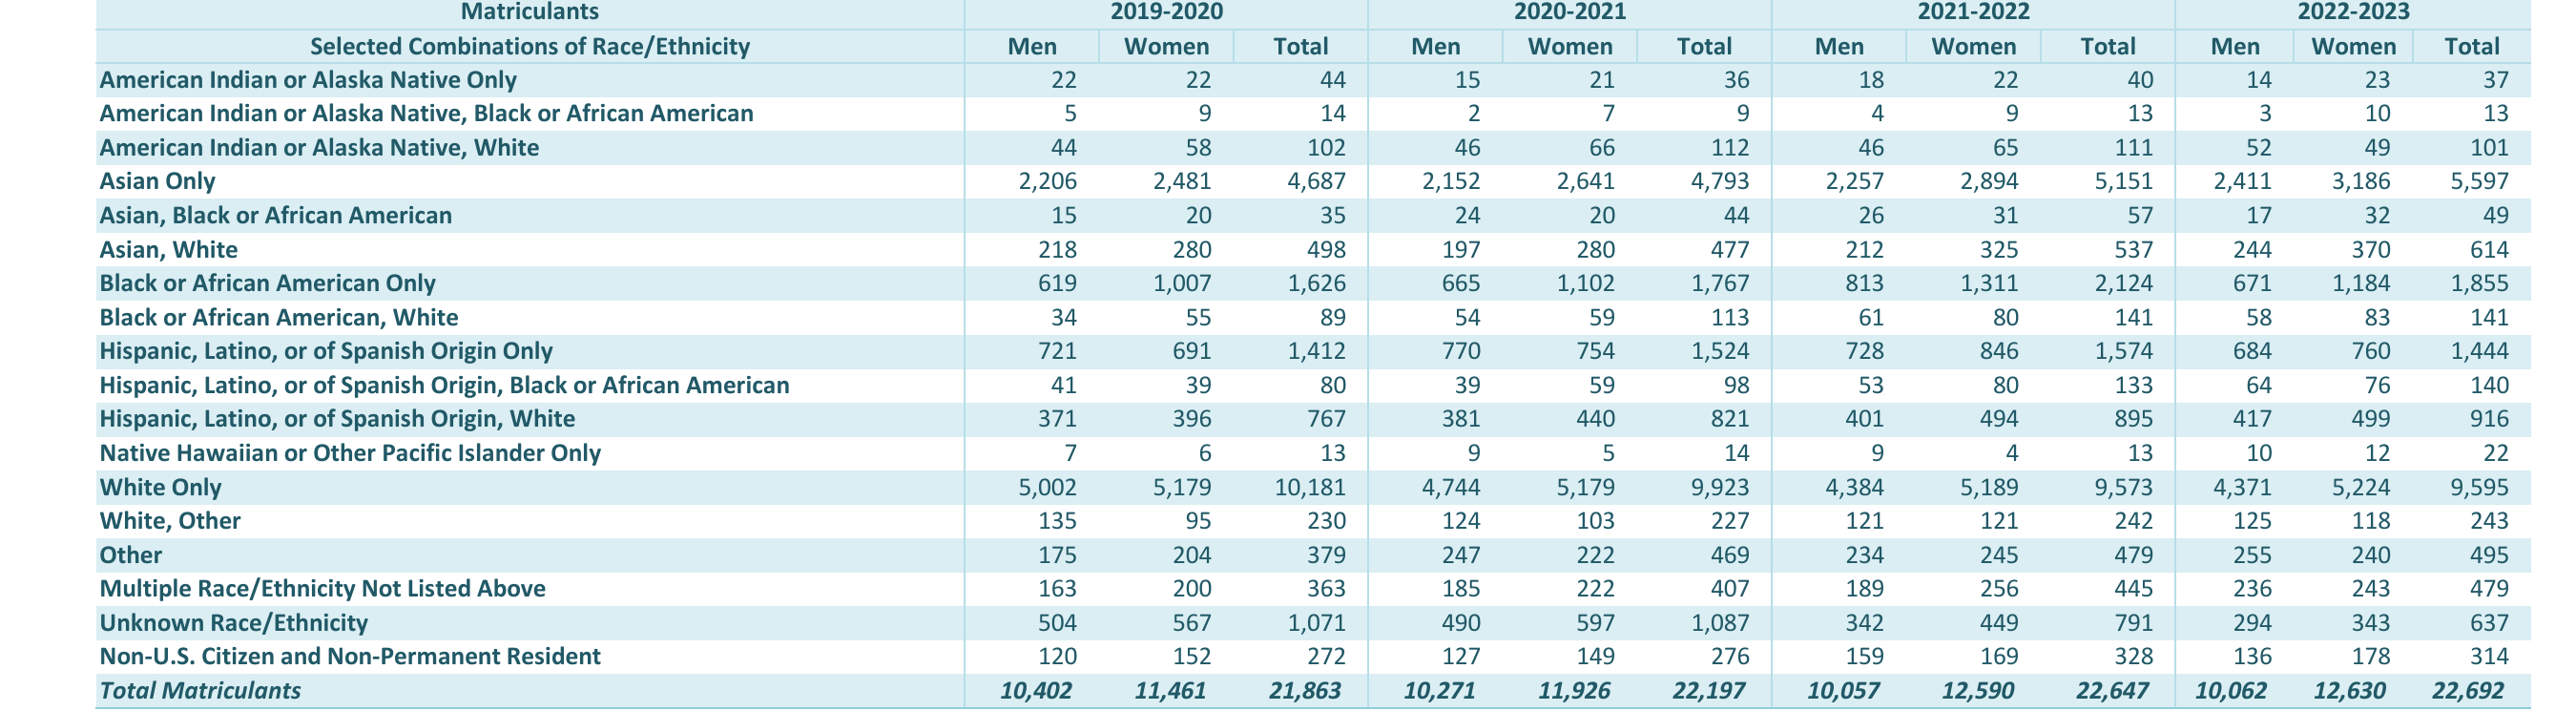
Table A-9: Matriculants to U.S. MD-Granting Medical Schools by Race, Selected Combinations of Race/Ethnicity and Gender, 2019-2020 through